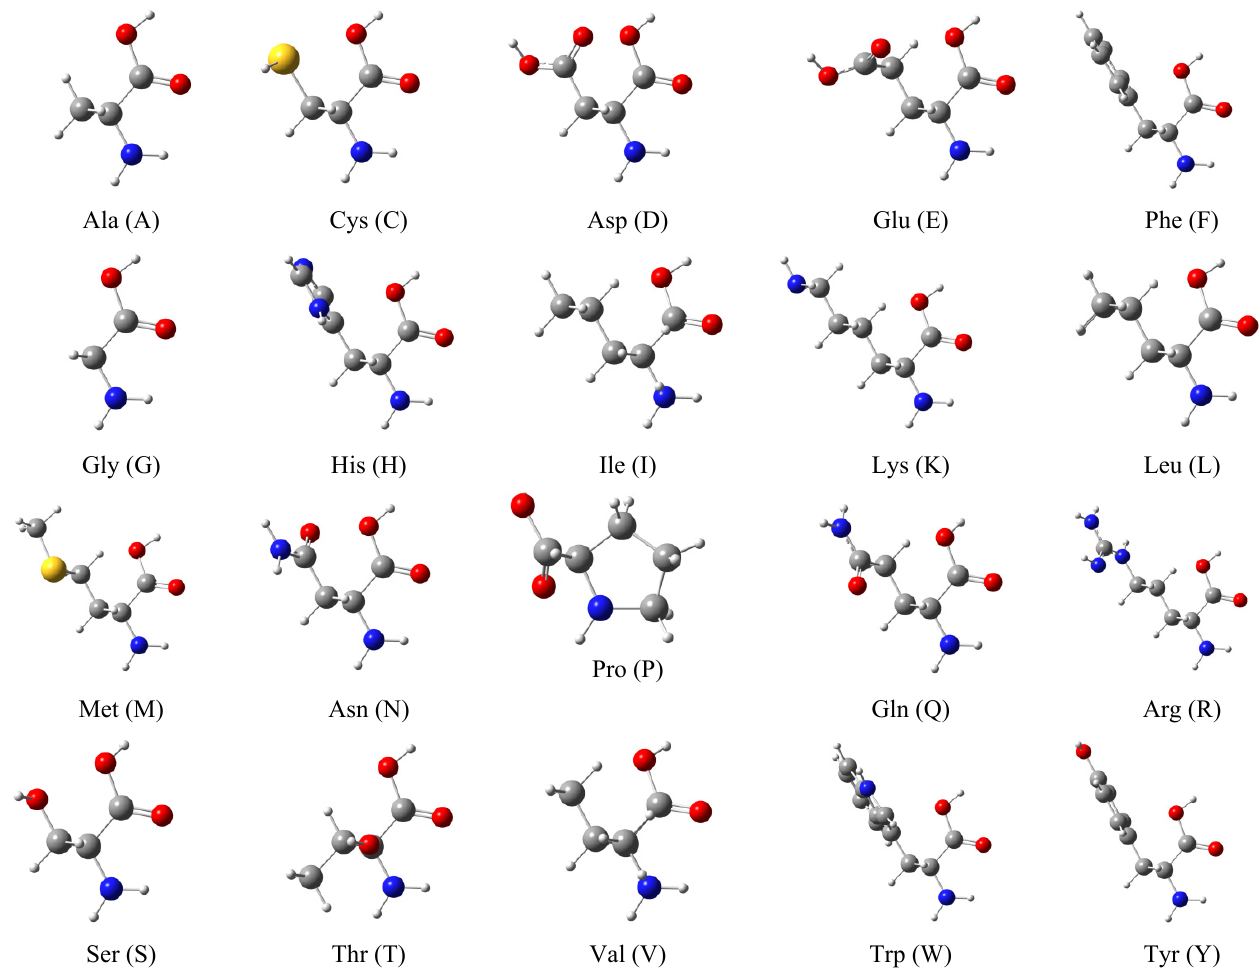
Scheme 2. Schematic representation of 20 amino acids that form the basis of 400 dipeptides and 8000 tripeptides. Each molecule is named with a three-letter abbreviation and single-letter in the parenthesis. Color code: H in white, C in grey, N in blue, O in red, and S in yellow.